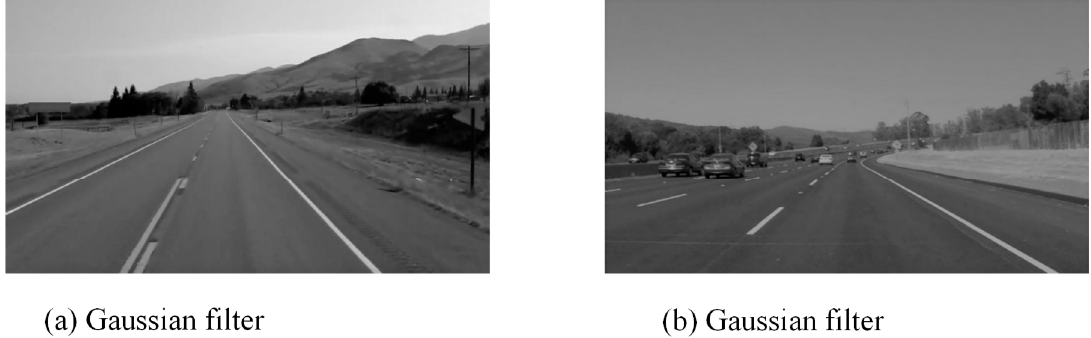
Figure 3. Using Gaussian filter on ( a ) a1 and ( b ) b1 from Figure 2.